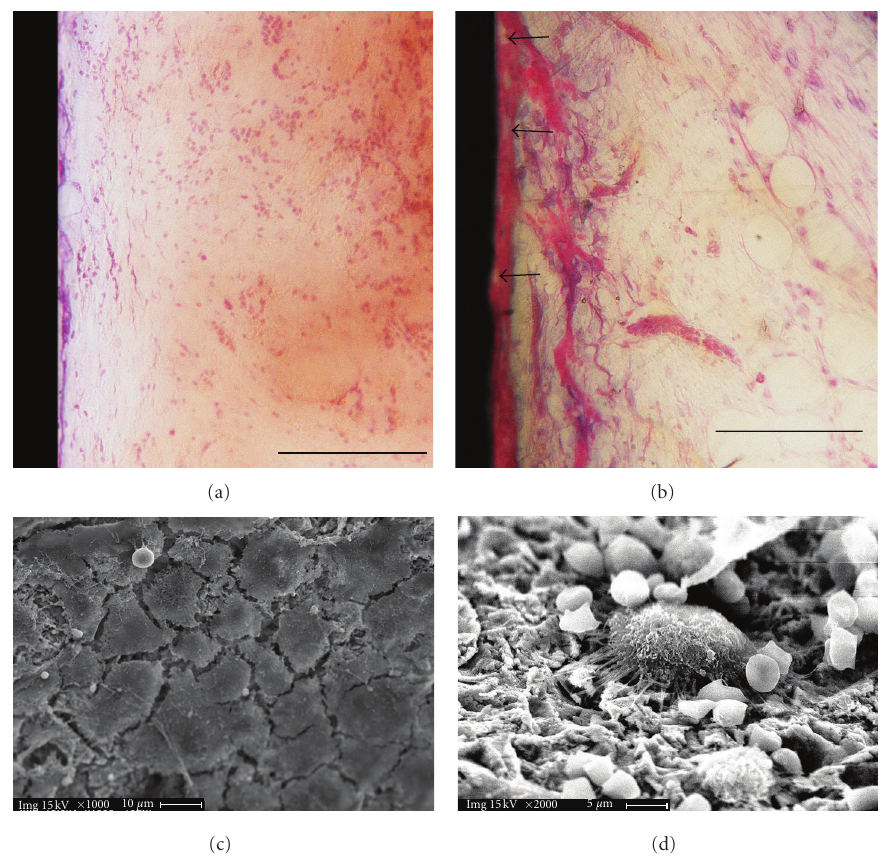
Figure 5: Day 6. Histology of longitudinal ground sections of MS (a) and SLA (b) surfaces. Empty osteocytic lacunae (arrows). LM, toluidine blue, and acid fuchsin staining. Bar = 100 µ m. Scanning electron microscopy of deacrylated ground sections of SLA implants: spreaded polygonal osteoblast-like cells (c) and osteoclast-like cell presenting a ru ffl ed border (d) adherent to the metal surface. Since the samples were initially processed for light microscopy (bu ff ered formalin fixative) and afterwards deacrylated for SEM observation, the shrinked appearance of blood cells might be considered as an artifact due to the formalin